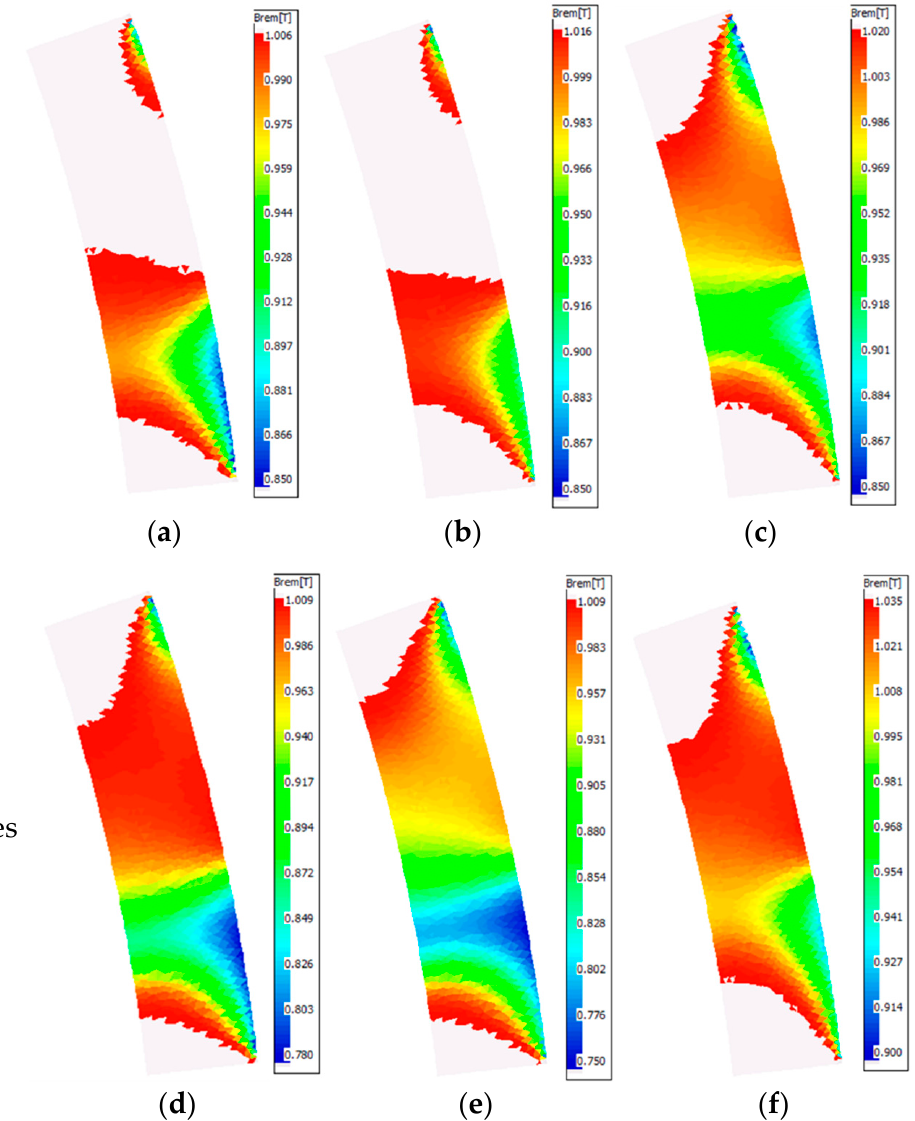
Figure 18. Remanence distribution of the PM obtained using the coupled EM-thermal model of Motor-CAD for ( a ) condition 1, T m ′ = 160 °C; ( b ) condition 2, T m ′ = 153 °C; ( c ) condition 3, T m ′ = 150 °C; ( d ) condition 1, T m ′ = 158 °C; ( e ) condition 2, T m ′ = 148 °C; and ( f ) condition 3, T m ′ = 140 °C.